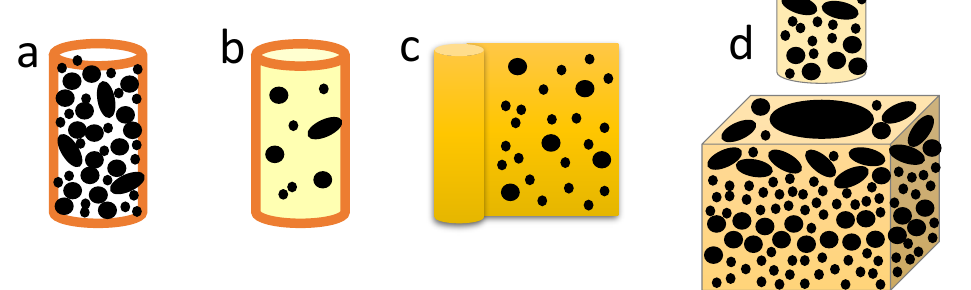
Figure 5. Sample preparation methods for loose particles. ( a ) Particles can be poured into a capillary. ( b ) Particles can be mixed with epoxy and cured inside a capillary. ( c ) Particles can be sprayed onto adhesive material such as wax or adhesive tape, and rolled into a cylinder. ( d ) Larger assemblies of particles can be infused with resin and then cored to obtain a smaller cylindrical